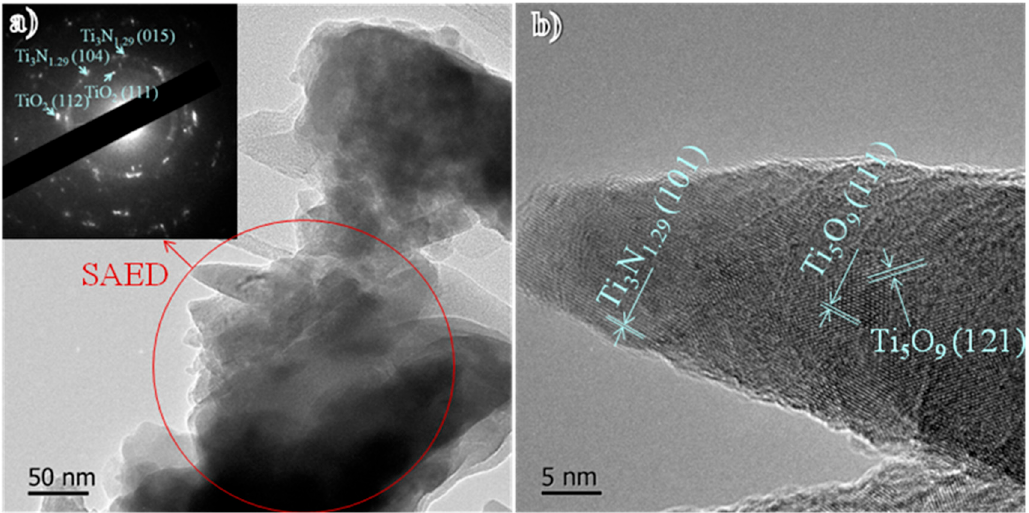
Figure 4. ( a ) Bright field transmission electron microscopy (TEM) image with selected area of the electron diffraction (SAED) pattern inset and ( b ) high resolution TEM (HRTEM) image of TiO x /TiN x film of Ti-MAO-N1.0.